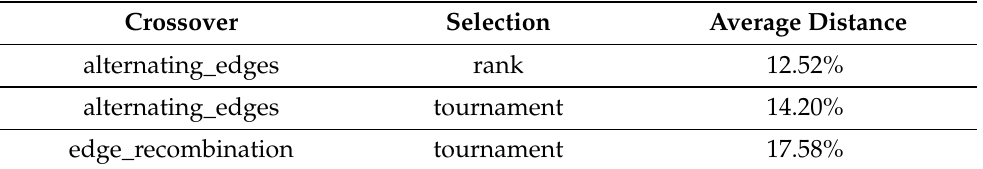
Table 10. Best combinations, long, large instances experiment—averaged data from all instances, grouped by selection and crossover combinations.